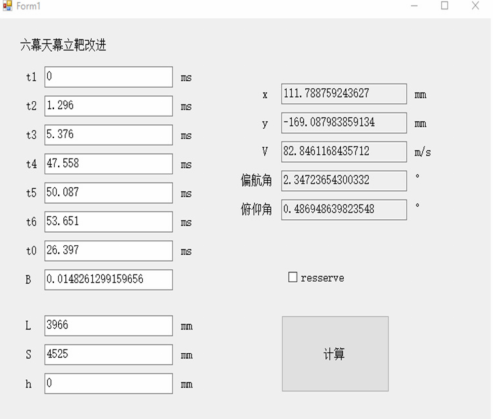
Figure 10. Interface for data acquisition and analysis system for photovoltaic conversion. t0~ t6 correspond to seven pulse times respectively; B is the attenuation coefficient; L is the distance between two light screen groups; S is the distance from the receiving light screen to the second screen; h is the height difference between two light screen groups; x and y are the abscissa and ordinate of the receiving light screen respectively; v is the velocity of the